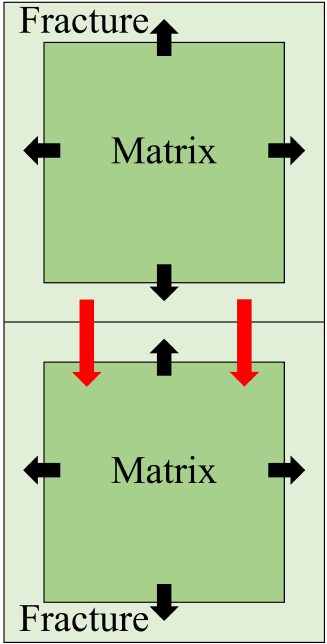
Figure 3. The oil allowed to flow from the matrix to the fractures as illustrated by black arrows (e.g., [15,17] models), while the allowed re-infiltration option is demonstrated by red arrows.